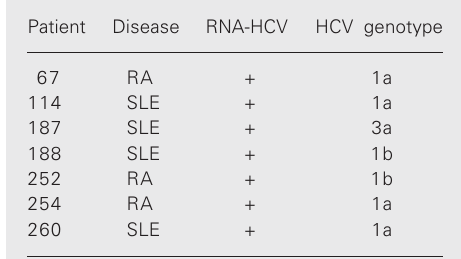
Table 2. Hepatitis C virus (HCV) genotypes in seven anti-HCV-positive patients with diffuse con- nective tissue